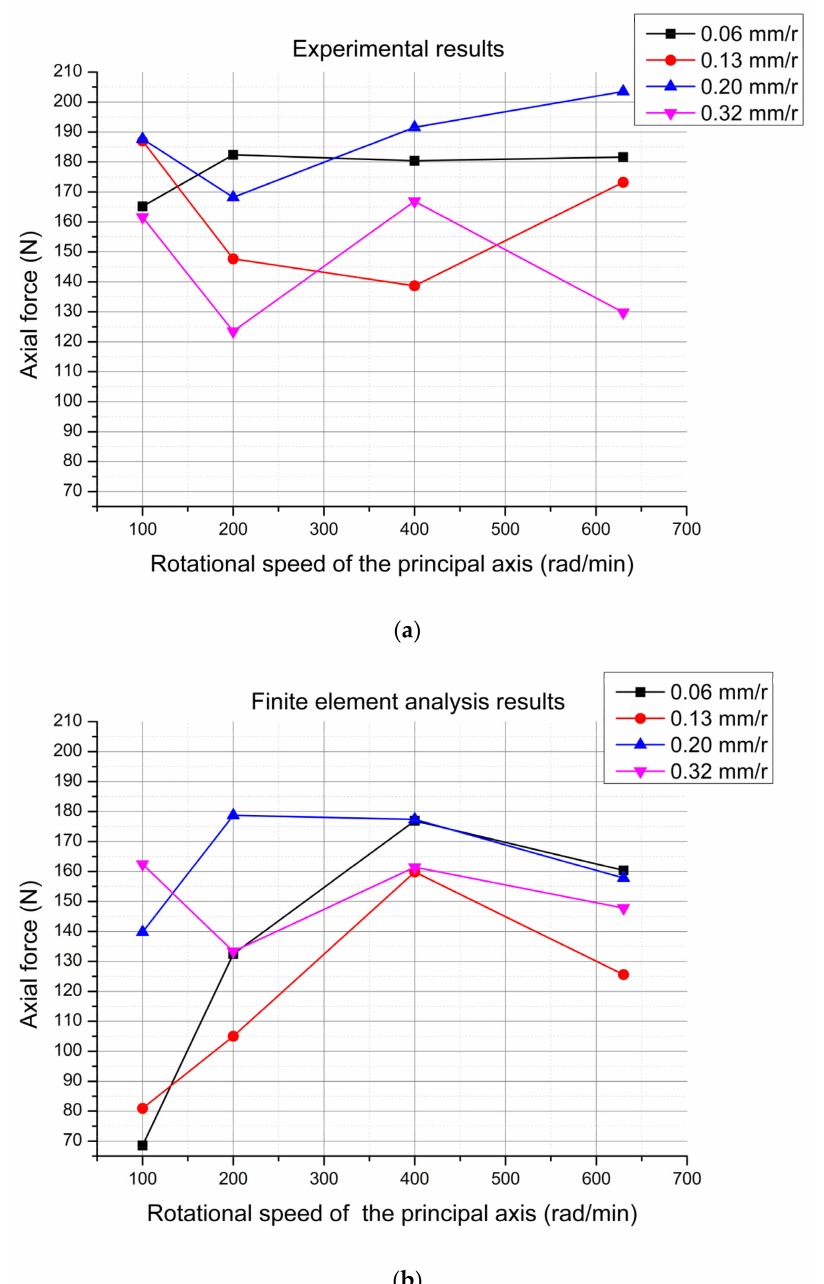
Figure 11. Experimental data 1 for sandstone. ( a ) During the test, the axial force changed with the rotational speed under different feed rates. ( b ) Finite element analysis results corresponding to the test